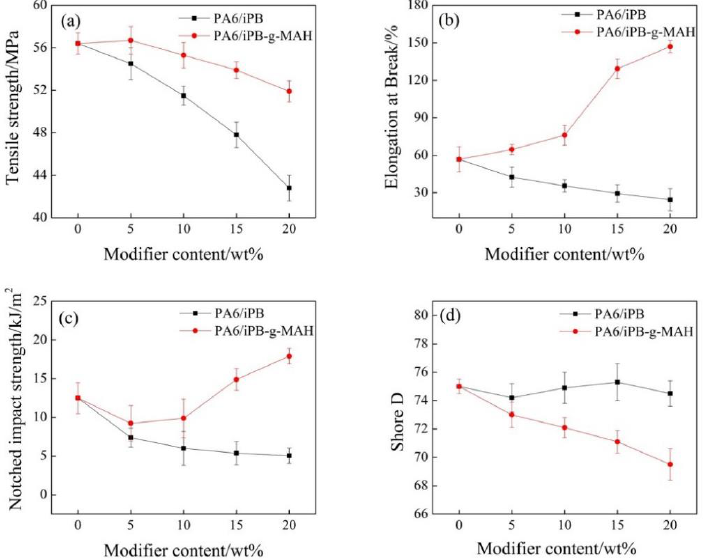
Figure 13. Effect of content of iPB and iPB-g-MAH in blends on blends mechanical properties. ( a ) Tensile strength; ( b ) Elongation at break; ( c ) Notched impact strength; ( d ) Shore D.